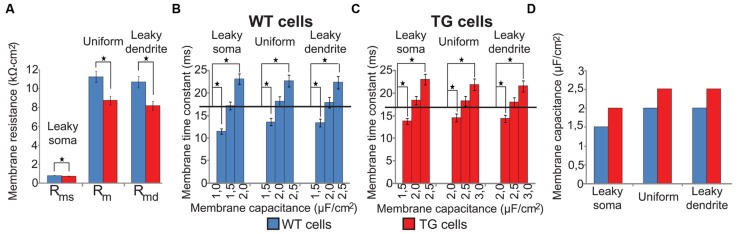
Specific membrane resistances and capacitances of modeled (WT, blue bars) and transgenic (TG, red bars) neurons in three soma-dendrite membrane models. (A) Specific membrane resistances were significantly smaller in TG than in WT neurons in all models. (B,C) Specific membrane capacitances of model WT and TG neurons were estimated by fitting simulated membrane time constants to their physiological values (black horizontal lines). (D) Specific membrane capacitance was bigger in TG than in WT neurons in all membrane models. Asterisks mark significantly different mean values (Mann–Whitney test, p < 0.05). Experimentally measured neuron resistances were 127.7 ± 9.0 MΩ in WT vs. 134.5 ± 9.2 MΩ in TG neurons and the difference was not significant (Rocher et al., 2008). In computer models of these neurons we used a common 130 ± 0.1 MΩ input resistance.